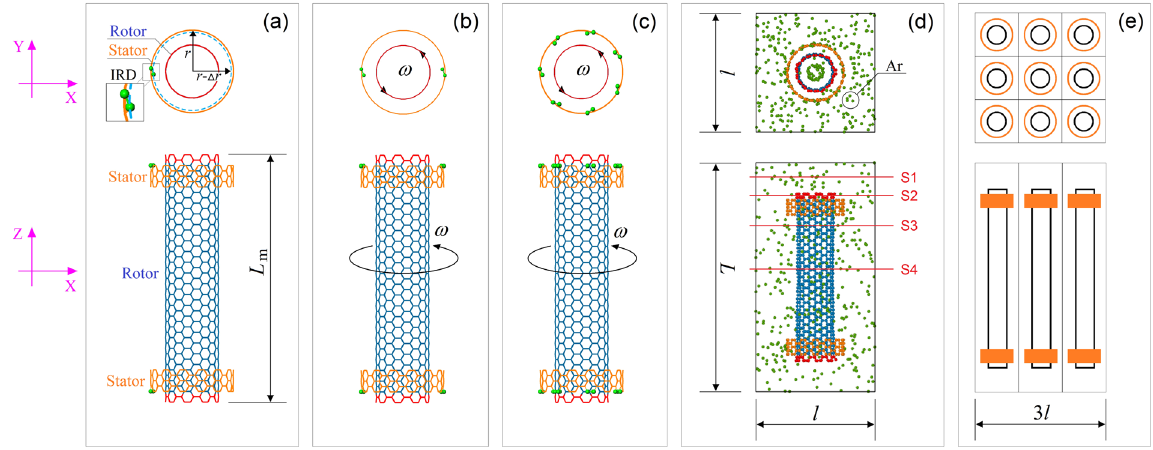
Figure 1. Schematic geometry of a thermally-driven rotary nanomotor made from (9,9)/(14,14) CNTs. ( a ) Each stator has IRD atoms ( N = 1), ( b ) N = 2, and ( c ) N = 7. The rotational frequency of the rotor is labeled “ ω ”. In the X-Y plane, the radial deviation ∆ r = 0.4 * l C-C = ~0.0568 nm with l C-C = ~0.142 nm. The initial distance along the tube axis between the neighboring ends of tubes is ~0.246 nm. The length of the inner tube (rotor) is L m = ~5.657 nm. The length of each stator is ~0.492 nm. The radii of the (9,9) and (14,14) CNTs are ~0.610 and ~0.949 nm, respectively. ( d ) Layout of the simulation box with sizes l × l × L . The motor is placed at the center of the box that is filled with argon atoms. S1, S2, S3, and S4 are cross-sectional slices for observation of local atoms. ( e ) Schematic array of 3 × 3